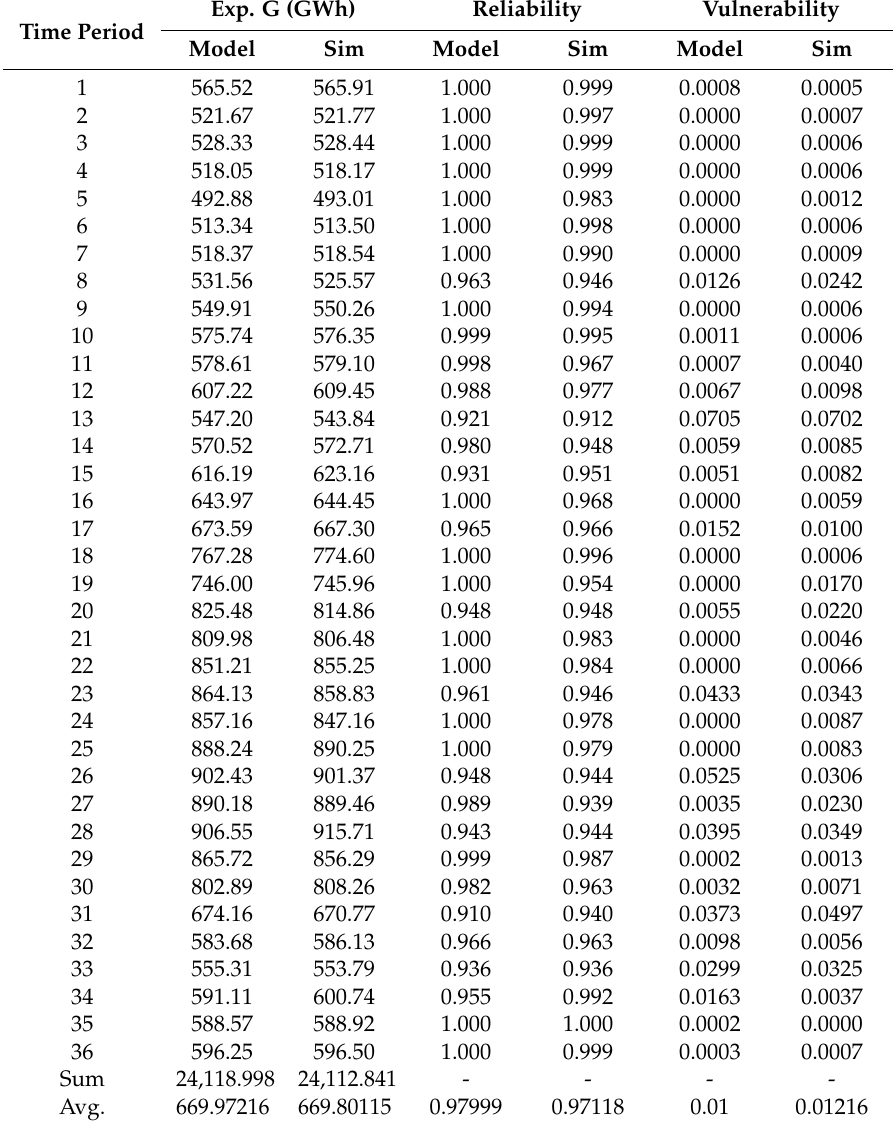
Table 2. Comparison of model and simulated (Sim) values of expected power generation (Exp. G), reliability, and vulnerability for each time period with ( Y , β , v ) = (1.778, 0.98, 0.01).